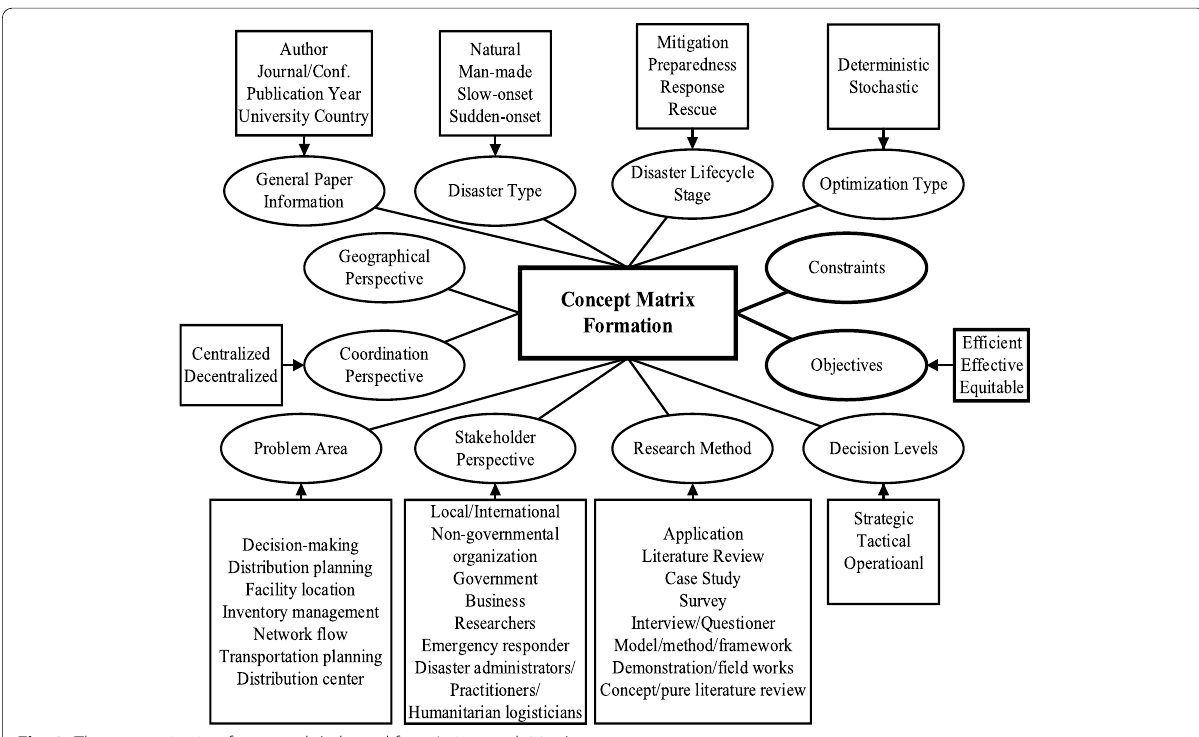
Fig. 3 The categorization framework (adapted from Leiras et al.